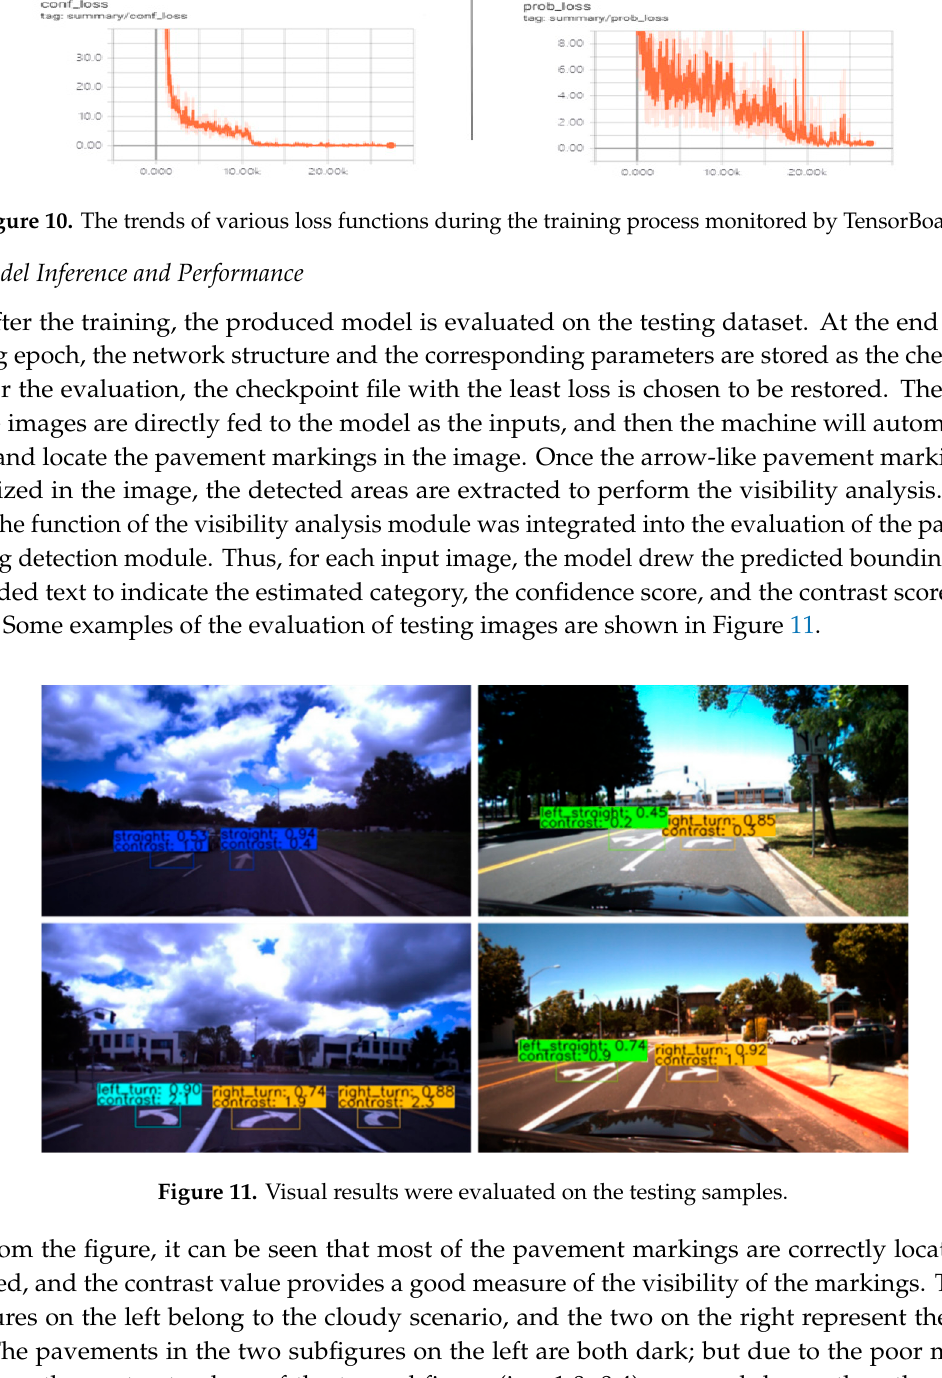
Table 1. Four categories of the metrics. Positive Predication